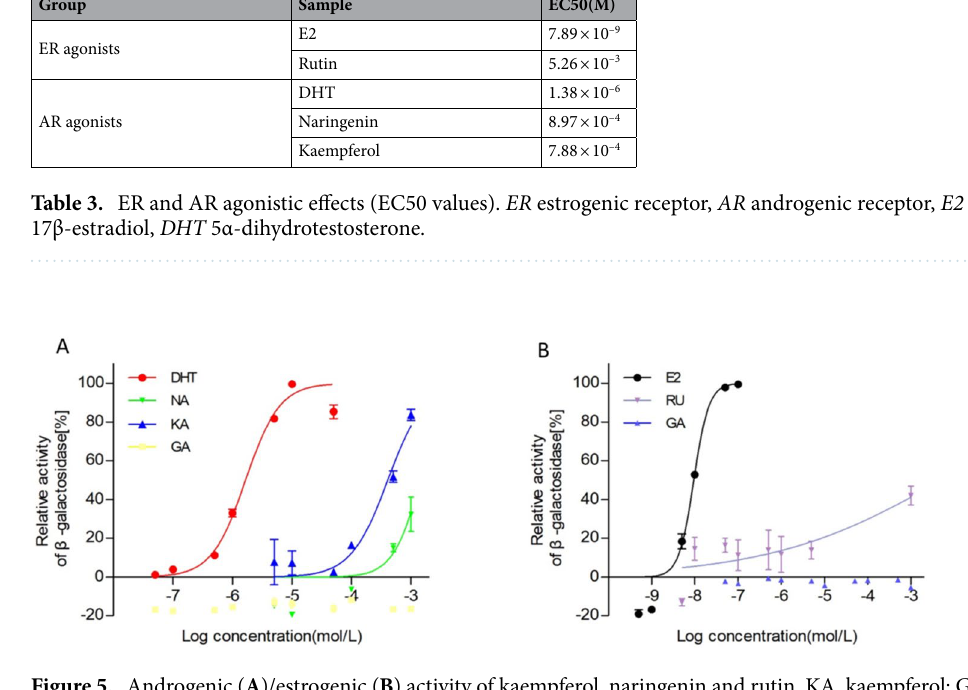
Figure 5. Androgenic ( A )/estrogenic ( B ) activity of kaempferol, naringenin and rutin. KA, kaempferol; GA, geniposidic acid; NA, naringenin. RU,